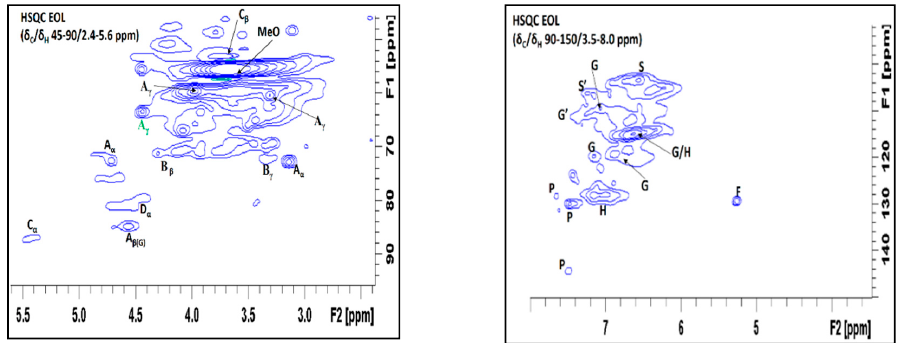
Figure 3. HSQC Spectra showing side chain and aromatic/unsaturated regions for TC extr and TC lignin isolates (MWL, ILL and MWL), assignment in Table S2 (Supplementary Materials). Key: Symbols for acetylated units are in green highlight; β -O-4 alkyl-aryl ethers, including C γ -H γ in γ -acetylated β -O-4 ′ substructures ( A ); Resinols ( B ); Phenylcoumarans ( C ); Spirodienone ( D ); Cinnamyl alcohol end groups, include C γ -H γ in cinnamyl acetate end groups (J); p -coumaric and ferulic acids (P&F); β - D - Mannosyl (mannose residues) ( β -D m ); α - D -Galactosyl (galactose residues) ( α -D ga ); β - D -Glucosyl (Glucose residues) ( β -D); C2 − H2 in 2-O-acetyl- β - D -xylopyranoside (X2); C3 − H3 in β - D -xylopyranoside (X3); C4 − H4 in β - D -xylopyranoside (X4); Unknown (U).